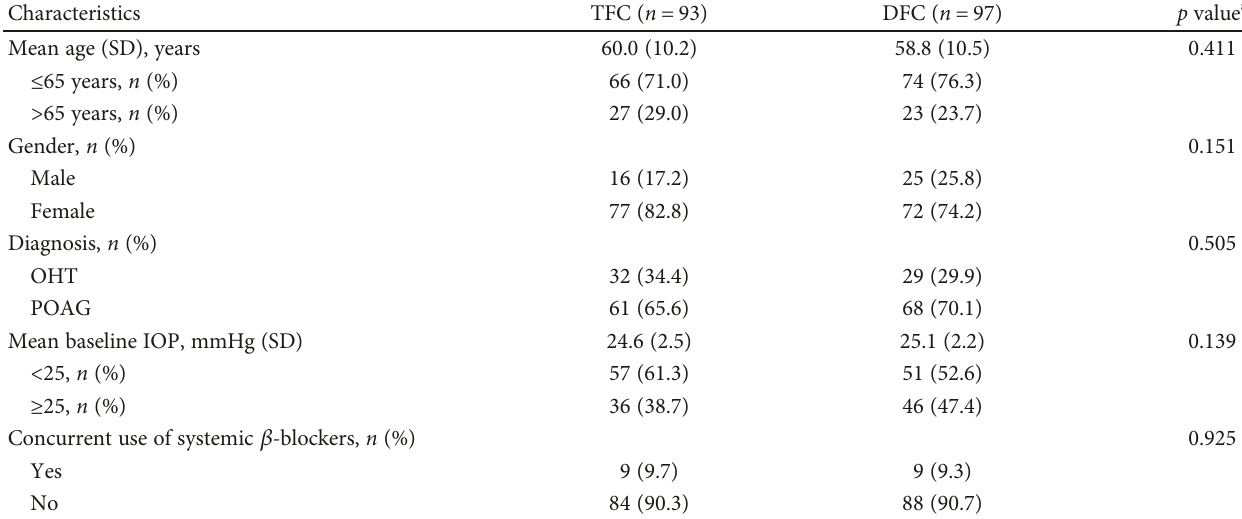
Table 1: Baseline demographics and patient characteristics (modi fi ed intent-to-treat population).